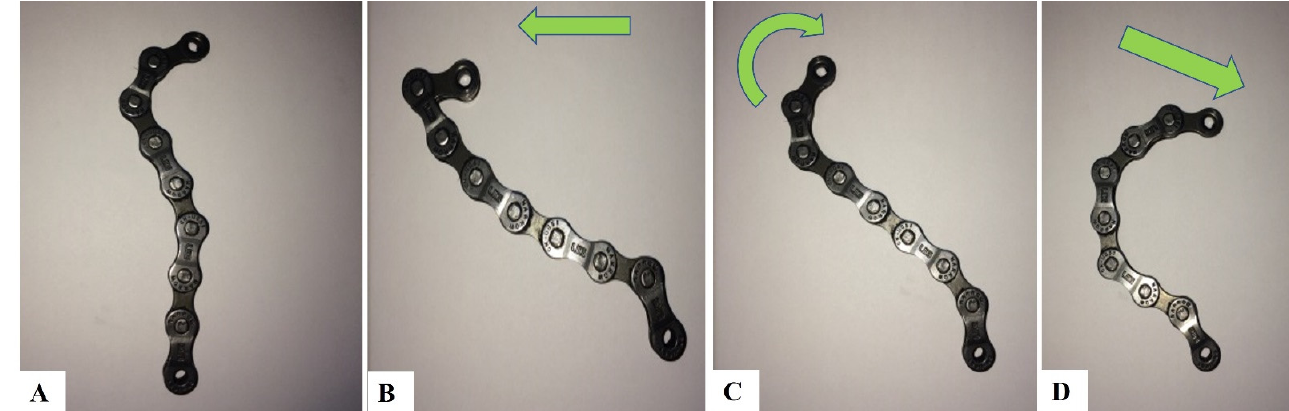
Figure 2. A simple bike chain analogy of the sequence of movements for the CBP group’s mirror image exercise and its proposed effect on the sagittal cervical spine alignment. ( A ) depicts neutral alignment with an altered curve; ( B ) depicts forward head posture (+TzH); ( C ) depicts upper neck/head extension (-RxH); and ( D ) depicts the effects of posterior head translation (-TzH) with slight inferior compression (-TyH). Images courtesy of Curtis Fedorchuk, reprinted with permission [28,29].